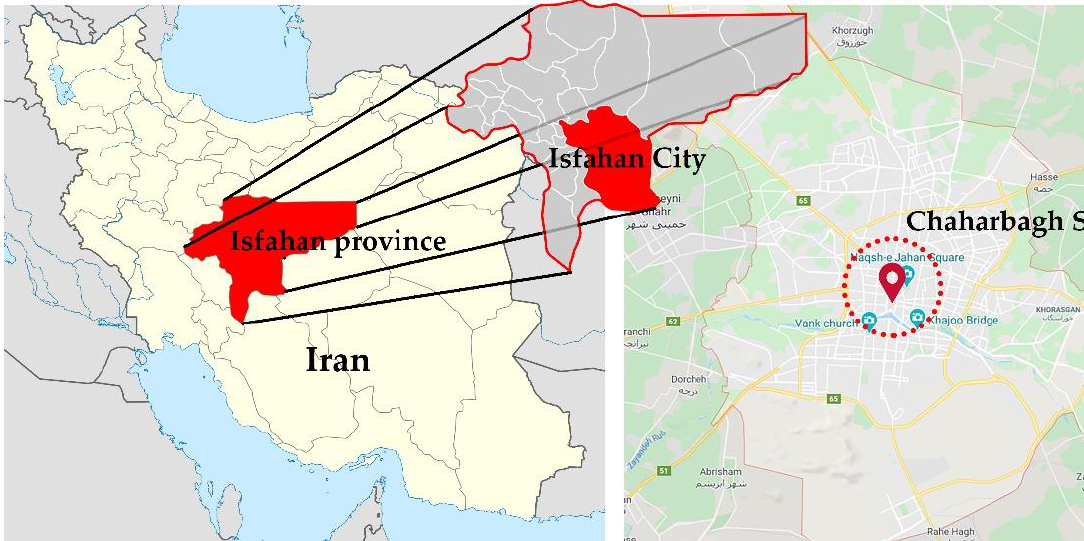
Figure 1. The location of Isfahan City and Chahar Bagh Street.